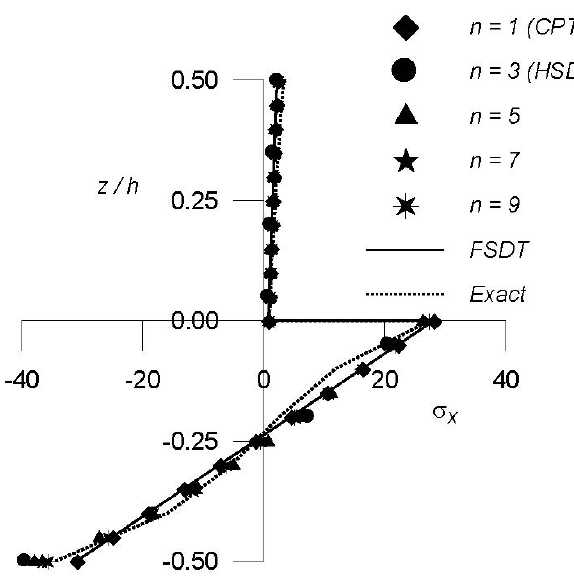
Figure 6: Through thickness distribution of bending stress ( ¯ σ x ) for simply supported two layered (0 ∘ /90 ∘ ) un-symmetrically laminated composite plates with a / h = 4 and E 1 / E 2 = 40